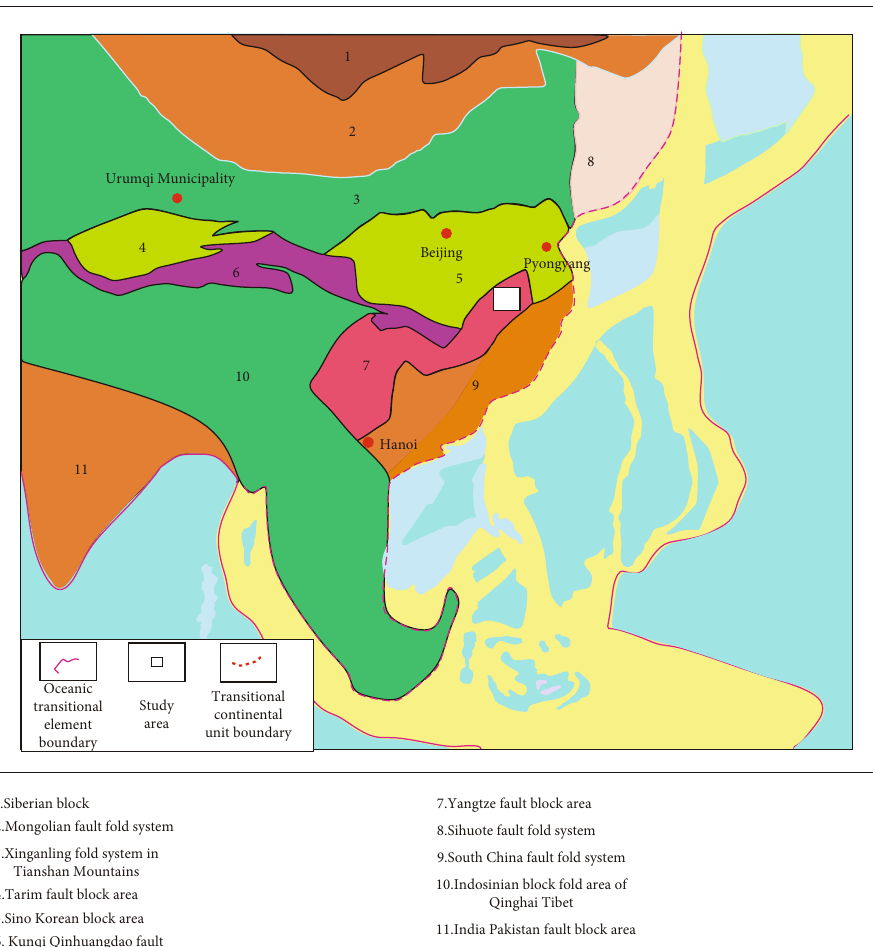
Figure 1: Tectonic location of the South Yellow Sea